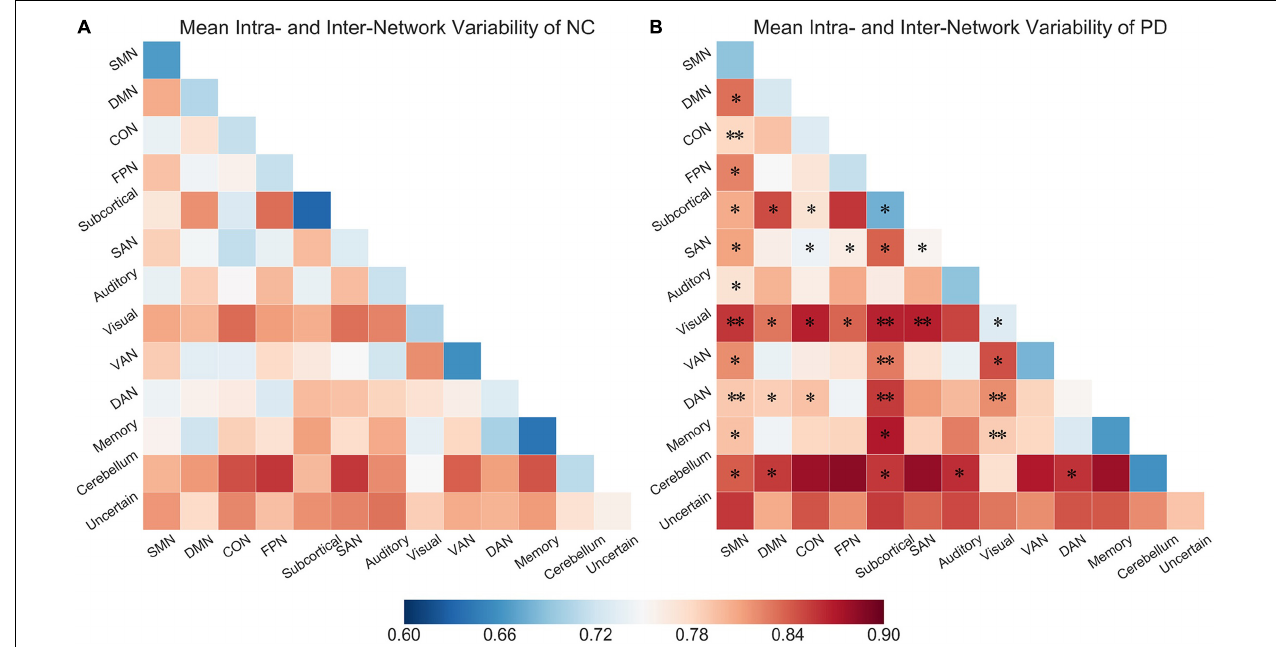
FIGURE 3 | (A) Mean intra- and inter-network variability matrix of NCs. (B) Mean intra- and inter- network variability matrix of PD patients. Asterisks ( ∗ ) labeled on the PD matrix indicate the subnetwork pairs showing significantly increased intra- or inter-network variability in PD patients compared than control subjects. ∗ p < 0.05, ∗∗ p <